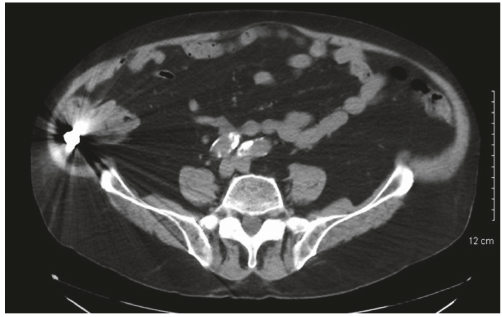
Figure 2: A CT abdomen and pelvis without contrast demonstrating the dental bridge persistently in the base of the